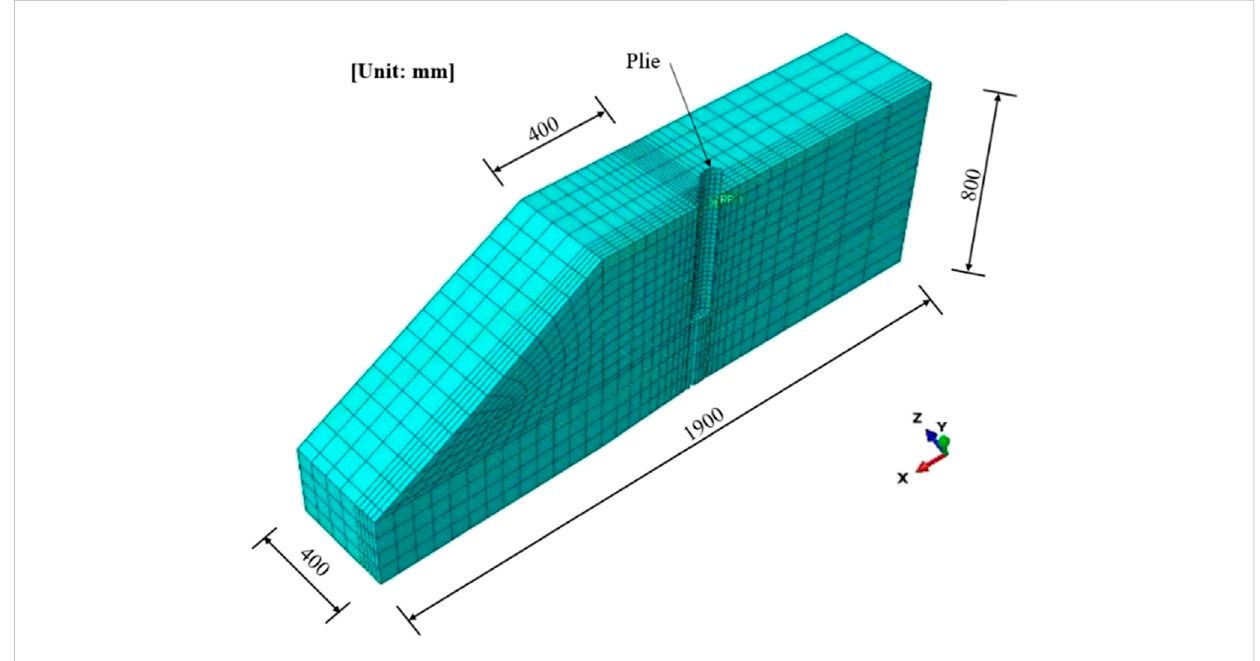
FIGURE 7 Symmetric 3D numerical model for a single pile with d pc = 4 D